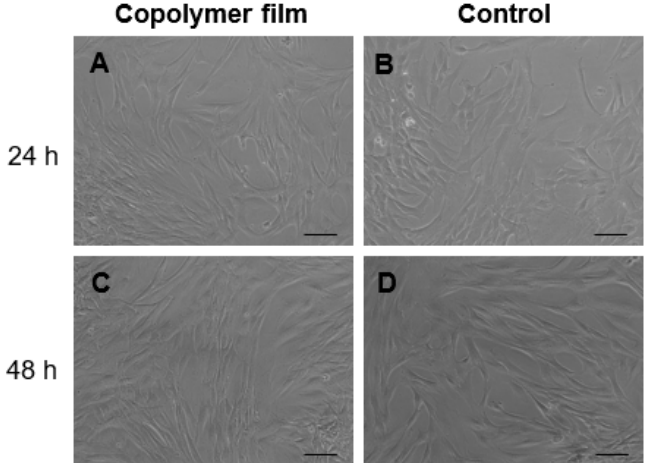
Figure 4. Results of the indirect cytotoxicity assay performed on P(VA-co-AA) copolymer film: micrographs acquired using a light inverted microscope of human dermal fibroblasts (hDFs) ( A , C ) treated with and ( B , D ) without conditioned culture medium (CM) for (A,B) 24 h and (C,D) 48 h. Scale bar is 100 µm.